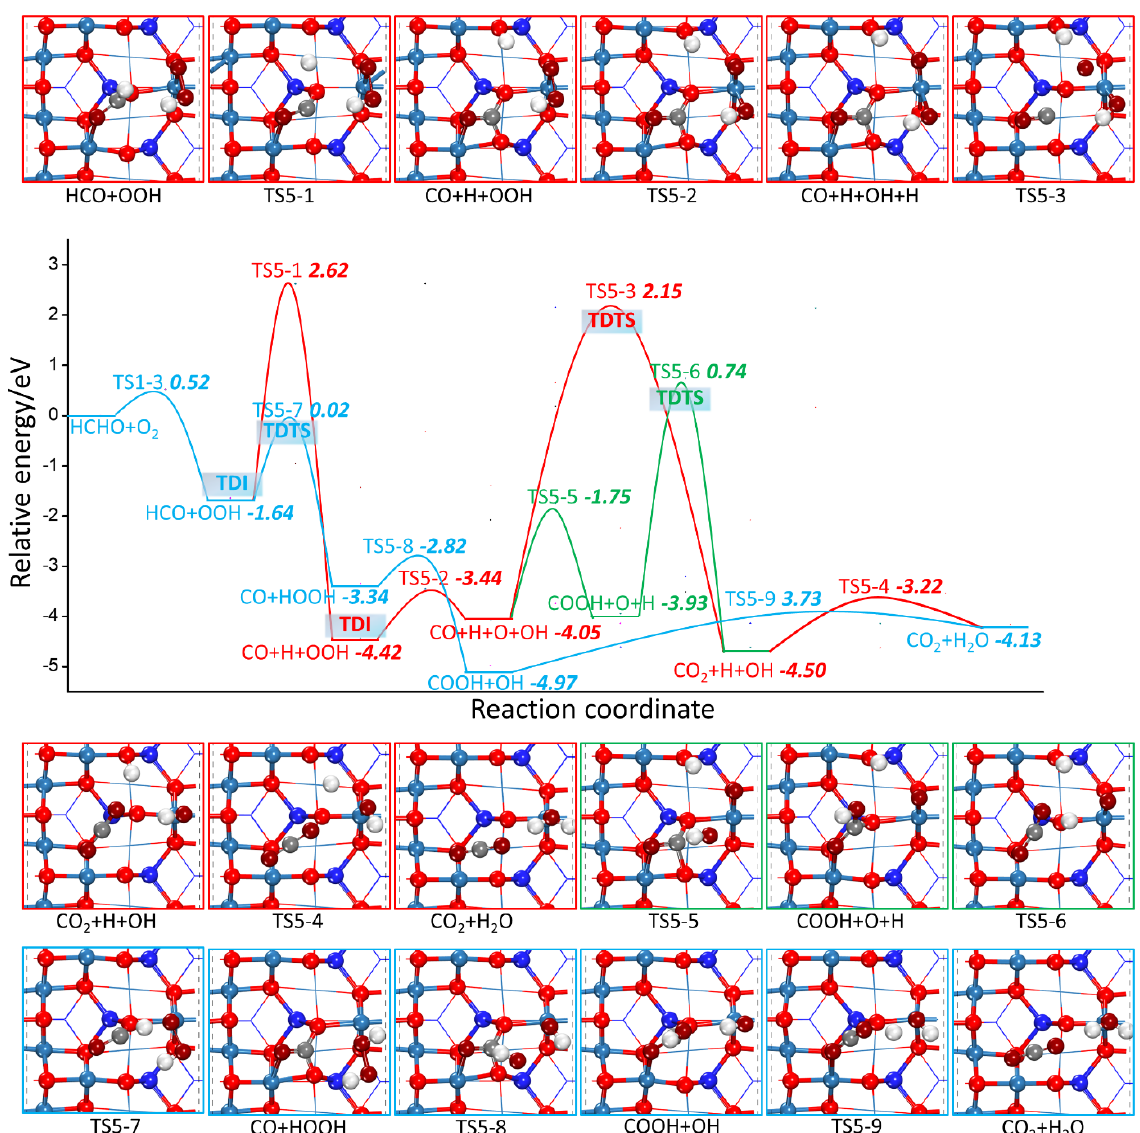
Figure 9. The potential energy profile of HCHO oxidation based on the L-H mechanism through CO grabbing the surface adsorbed oxygen species together with the structures of TSs and FSs on Co 3 O 4 (110) surface.